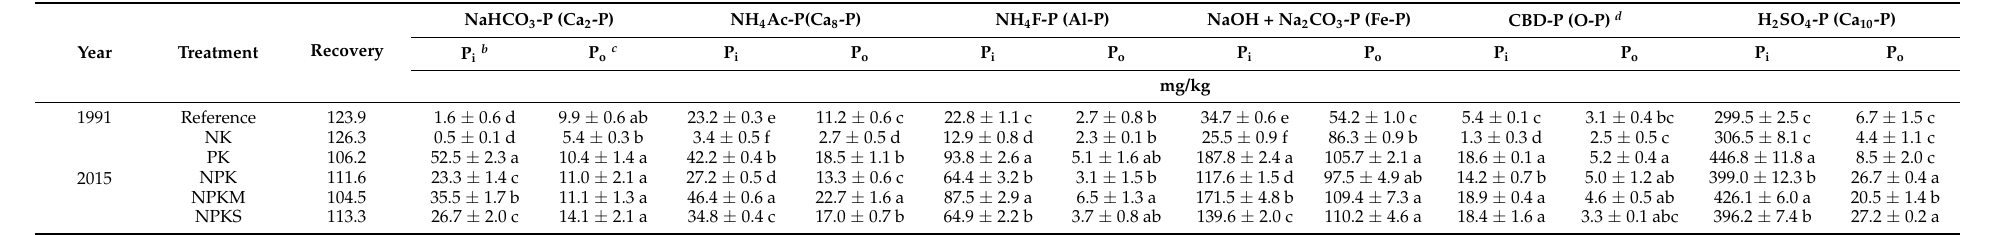
Table 2. Sequential fractionation results of P in the soils under various fertilization treatments a